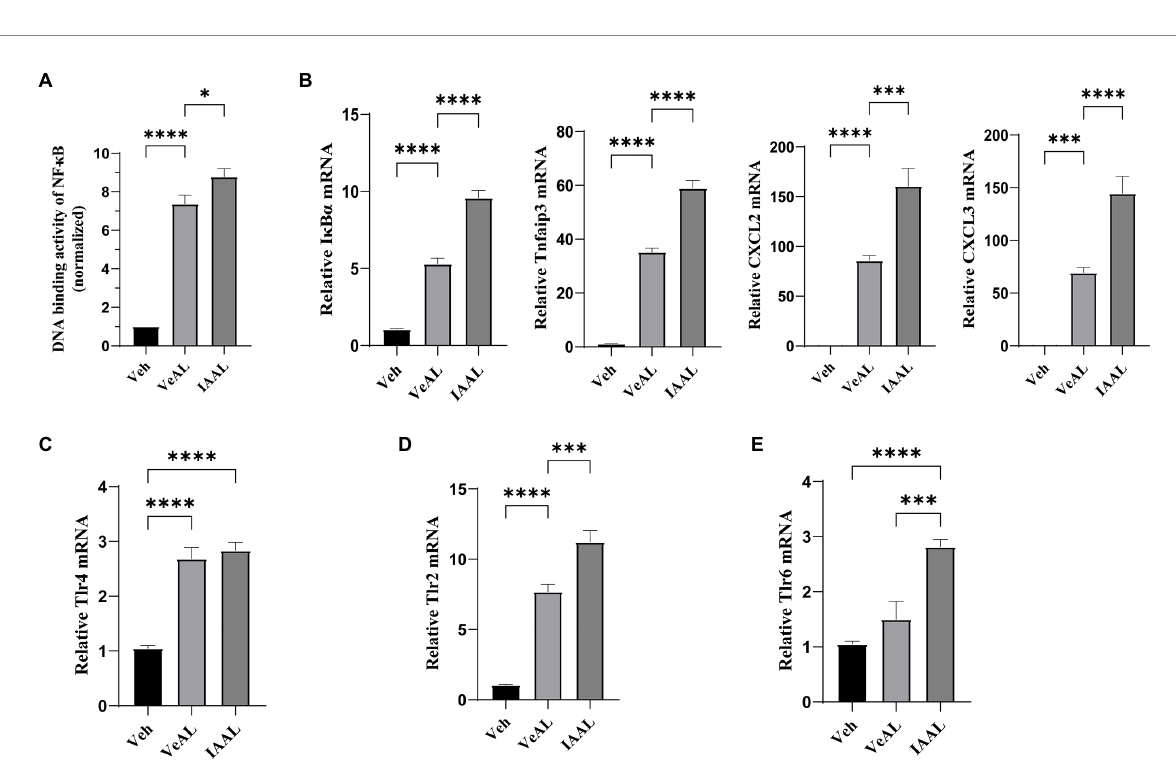
FIGURE 4 IAA enhanced the TNF- α /NF- κ B signaling pathway with the up-regulation of Tlr2 instead of Tlr4 signaling in D-GalN/LPS induced-ALF. (A) The transcriptive activity of NF- κ B (P65). (B) Relative expression of I κ B α , Tnfaip3, Cxcl2 and Cxcl3 mRNA in liver. (C–E) Relative expression of Tlr4, Tlr2, Tlr6 mRNA in liver. The data are presented as the mean ± SEM. * p < 0.05; ** p < 0.01; *** p < 0.001 and **** p < 0.0001 for the comparison. Veh, Vehicle (saline control); VeAL, Vehicle + D-GalN/LPS; IAAL, IAA + D-GalN/LPS. n = 10 in each